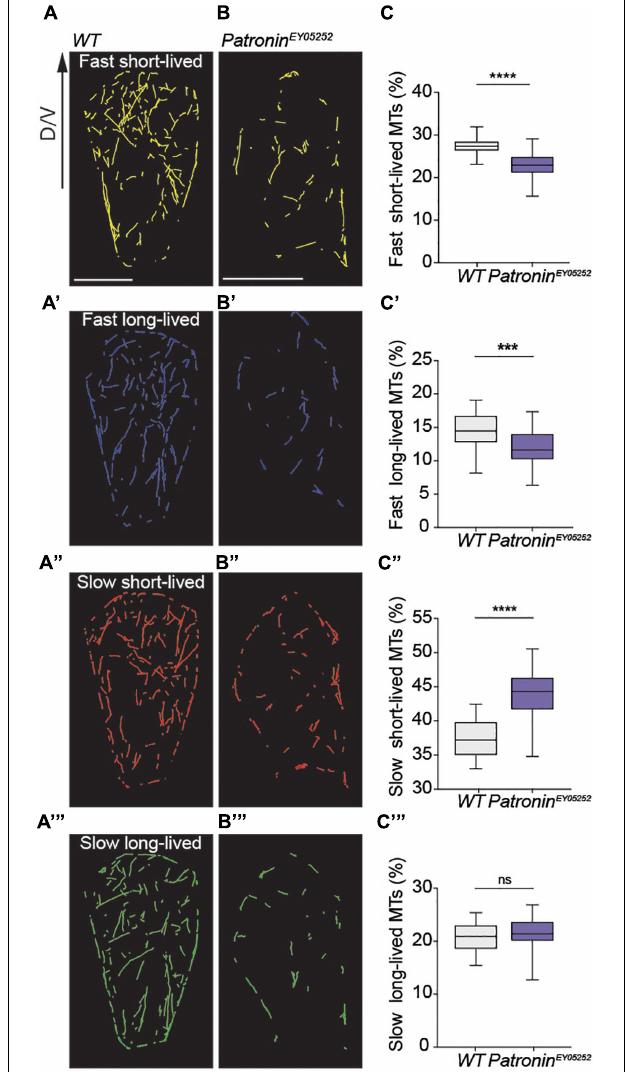
FIGURE 4 | Loss of Patronin leads to the reduction of the dynamic microtubules. (A–C”’) Proportions of microtubule subpopulation calculated based on mean growth speed and lifetime. (A–B”’) Sub-tracks for four distinct dynamic subpopulations of growing microtubules in a cell as, fast and short-lived (yellow), fast and long-lived (blue), slow and short-lived (red), and slow and long-lived (green) for a representative wild-type (A–A”’) and patronin ey 05252 mutant cell (B–B”’) . (C–C”’) Quantification of four distinct dynamic subpopulations in wild-type and patronin ey 05252 mutant histoblasts. Box plots show the percentage subpopulation for microtubules clustered based on growth speed and lifetime mean values. Graphs show box plots with a line indicating the mean and with maximum and minimum values. In all plots: ns, no significant difference; p < 0.001 (***); p < 0.0001 (****); and unpaired t -test Welch’s correction, number of microtubules ( n ) = 13,208), cells ( n ) = 28, and pupae ( N ) = 3 for wild-type and number of microtubules ( n ) = 9,184, cells ( n ) = 53, and pupae ( N ) = 11 for patronin ey 05252 mutant cells. Scale bar (A–B”) , 5 µ